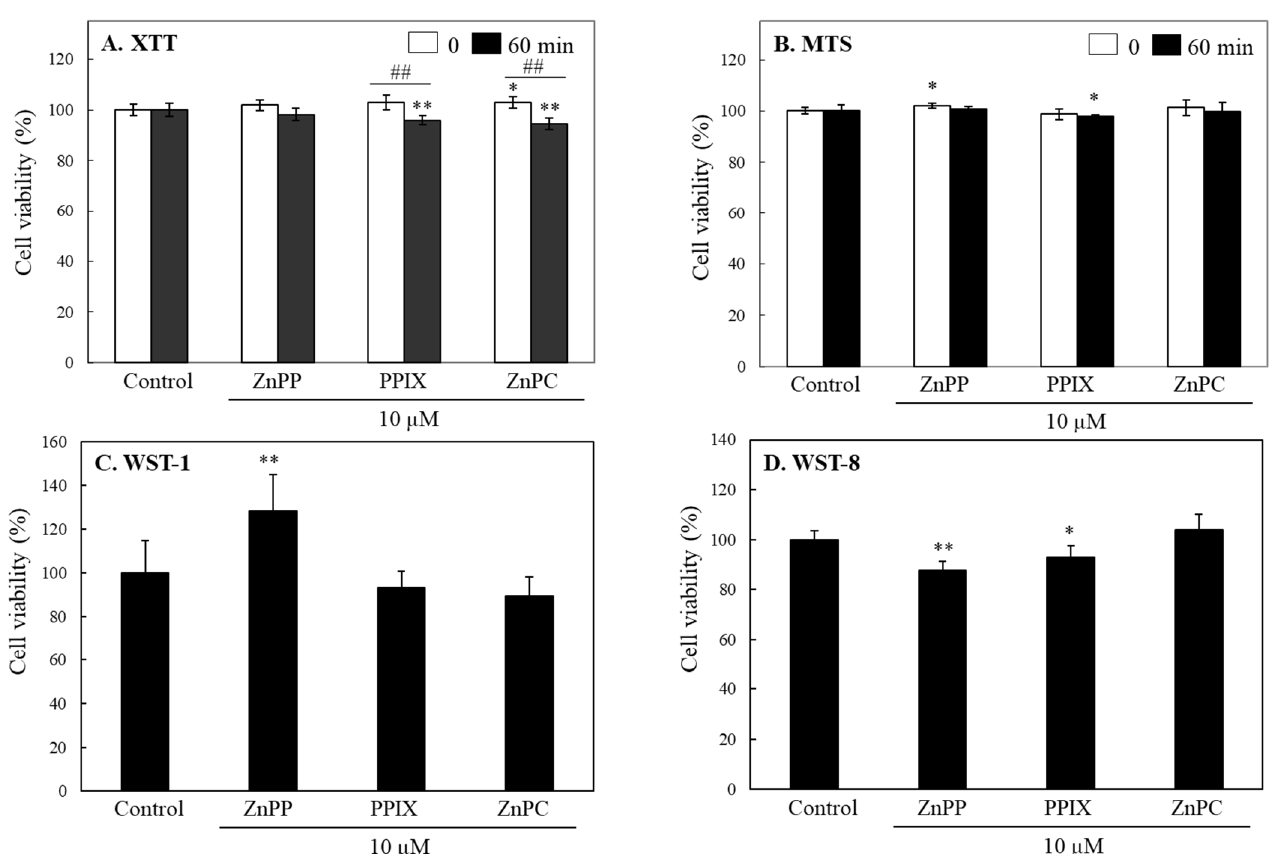
Figure 3. Effects of porphyrin derivatives on cell viabilities analyzed using different tetrazolium assays. INT407 cells were treated with each porphyrin derivatives (10 µ M) for 24 h, and formazan formed by cells from XTT ( A ) and MTS ( B ) tetrazolium was analyzed at 0 and 60 min. Effects of three porphyrin derivatives on cell viability were also analyzed after 24 h treatment using WST-1 ( C ) and WST-8 ( D ) tetrazolium. Each value represents the mean ± S.D. ( n = 6–8). *, ** Significantly different from control or ## between 0 and 60 min according to Student’s t -test (*, p < 0.05; **, ##, p <